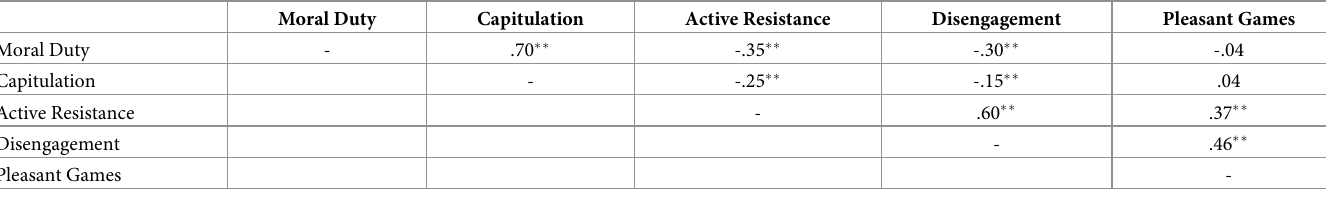
Table 2. Pearson’s r correlations showing relationships between scores on the five scales.